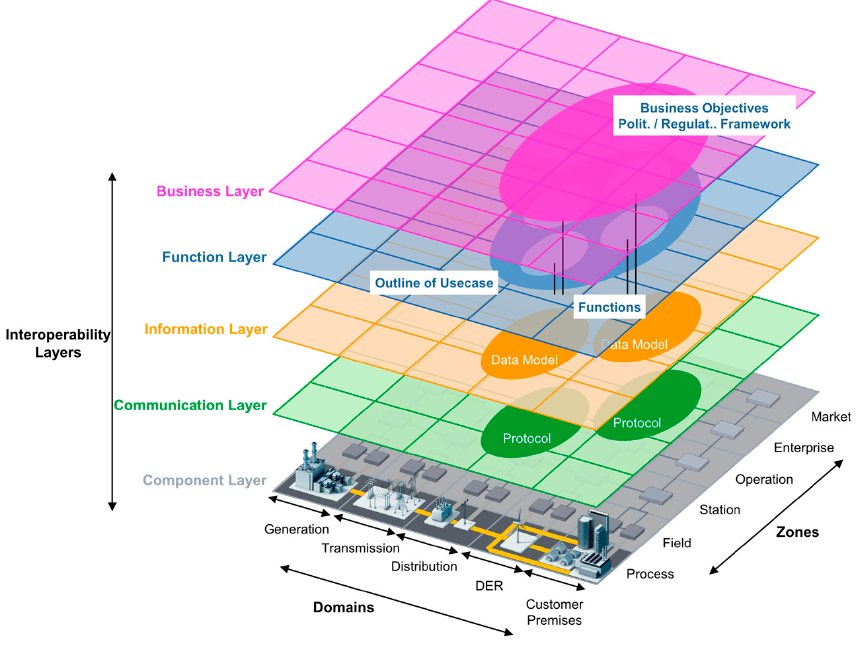
Figure 2. High level representation SGAM [40].